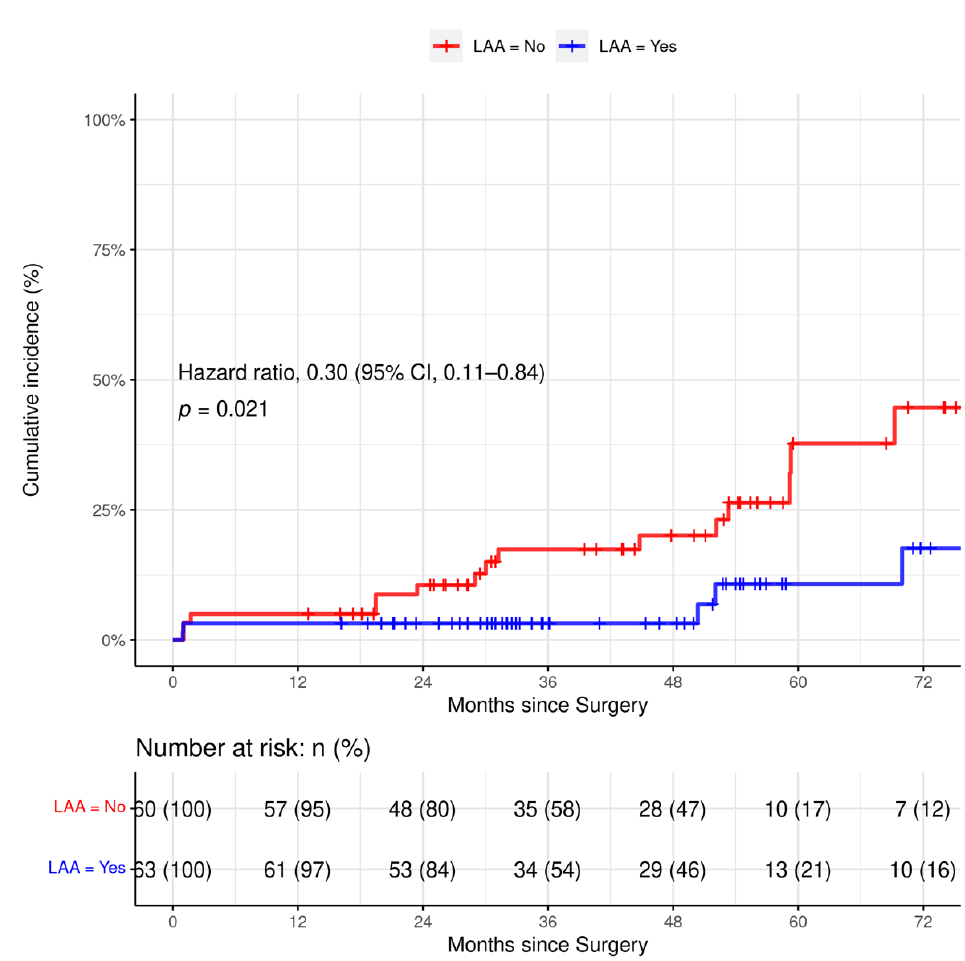
Figure 2. Incidence of cumulative ischemic stroke in matched patients with left atrial appendage vs. without left atrial appendage amputation. Table 3. Outcomes of patients with LAA vs. No-LAA amputation at follow-up, unmatched and matched with respect to